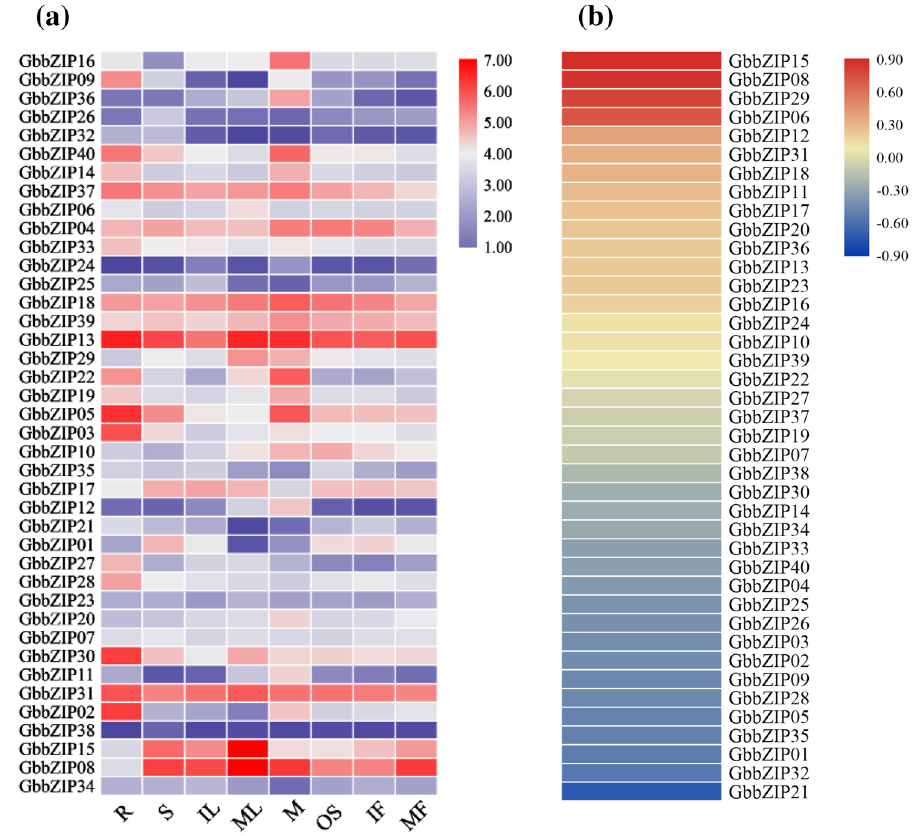
Figure 6. ( a ) Expression pattern of GbbZIPs in the 8 tissues base on the FPKM in the transcriptome data. ( R root, S stem, IL immature leaf, ML mature leaf, M microstrobilus, OS ovulate strobilus, IF immature fruit, MF mature fruit). ( b ) Correlation analysis (p < 0.05) of the content of flavonoid and the FPKM of GbbZIPs in 8 tissues base on the FPKM in the transcriptome data.